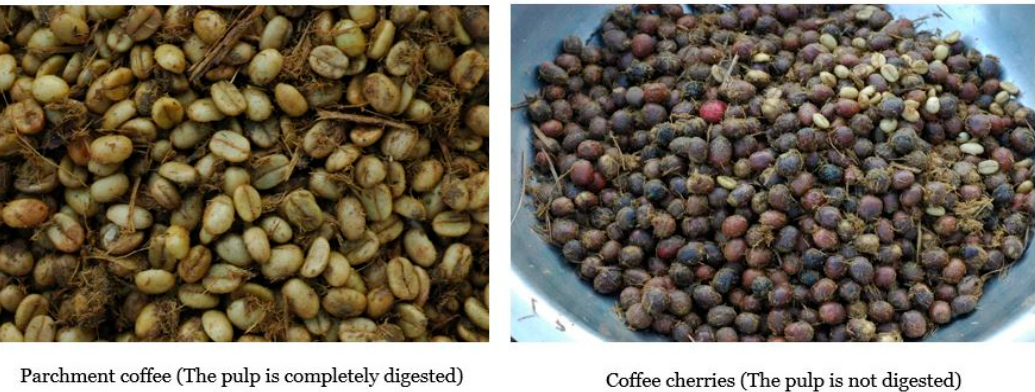
Figure 1. The elephant dung coffee right after the coffee cherry passed through the elephant digestive tract and collected from the elephant tract and collected from the elephant feces.